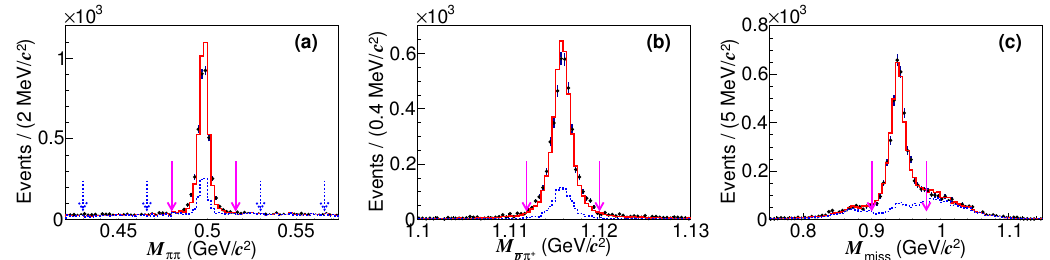
candidates, (b) M of the ¯Λ candidates, and (c) ¯ pπ + S